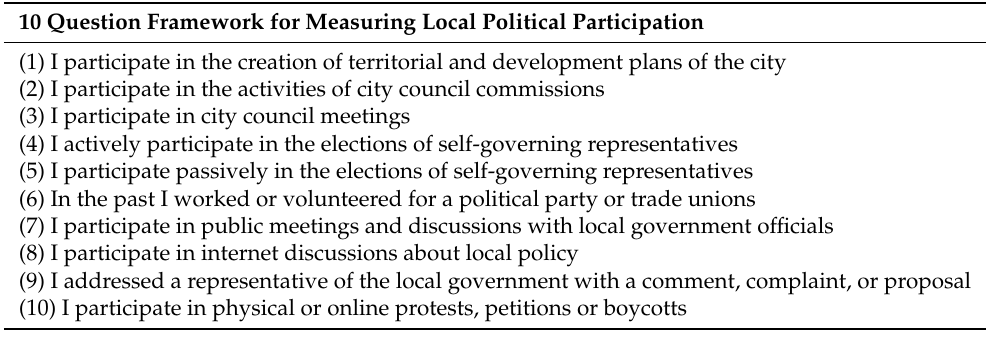
Table A3. 10-question framework for investigation of local political participation